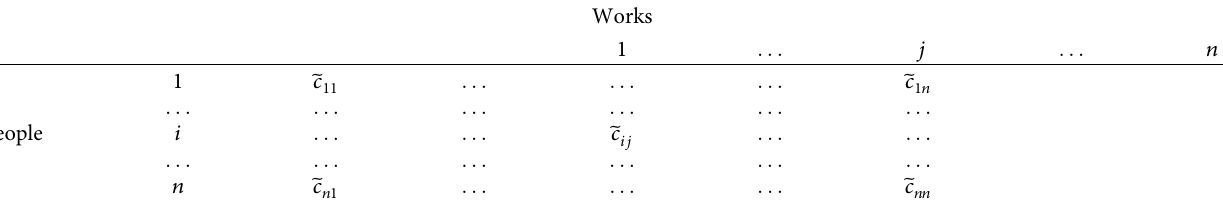
Table 1: Fuzzy assignment problem.